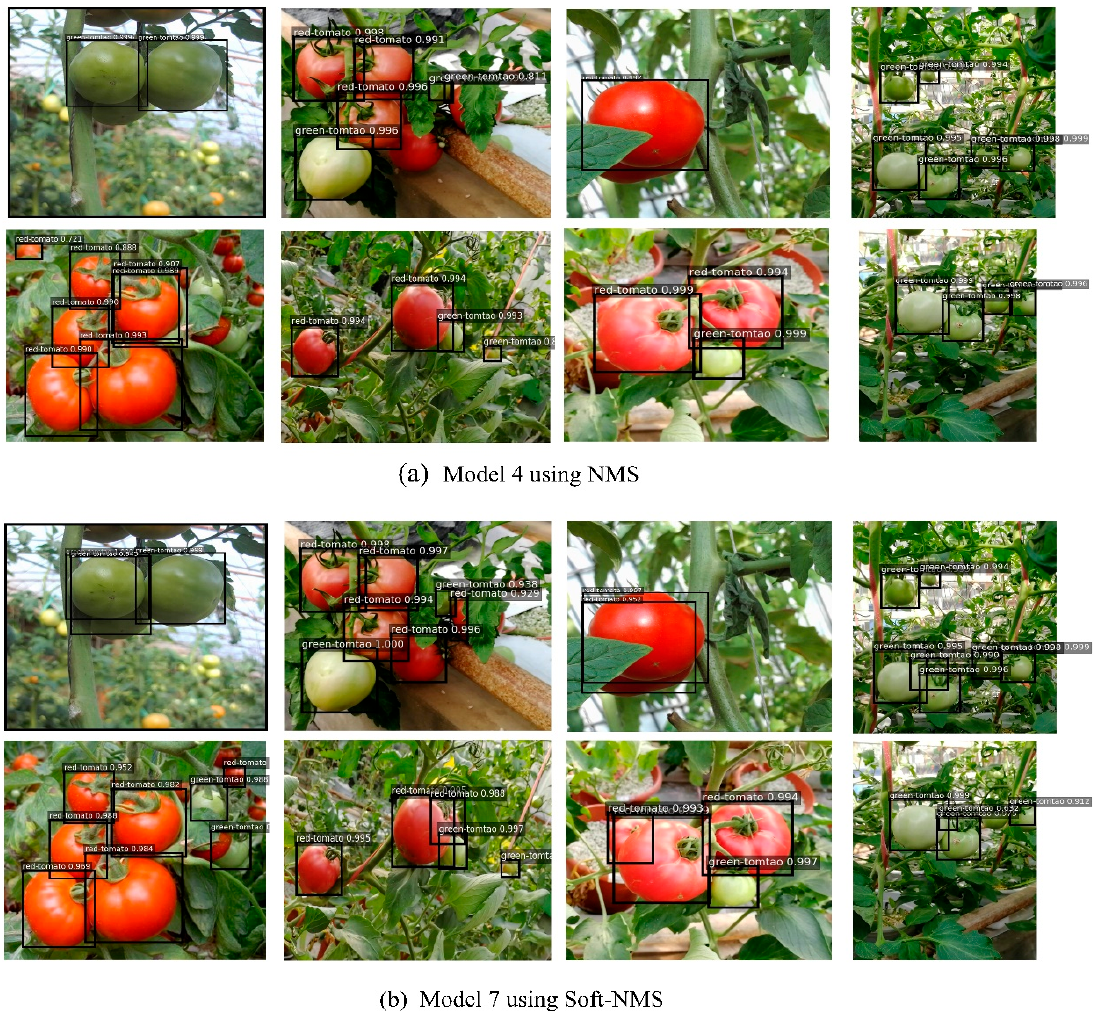
Figure 7. Visualization of detection performance in the case of overlap and occlusion. ( a ) Detection of